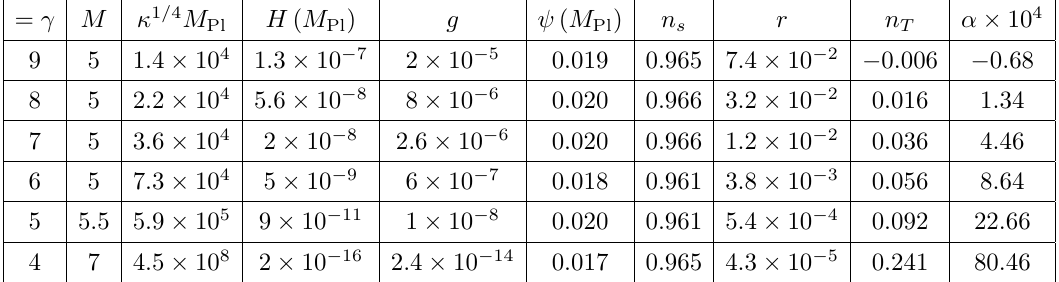
Table 1 . Potential parameters and observables for the black dots shown in (cid:12)gure 11. The value of the Hubble scale is given at N = 60 e -folds before the end of in(cid:13)ation. The value at the end of in(cid:13)ation is approximately 8 times smaller for the parameters in this